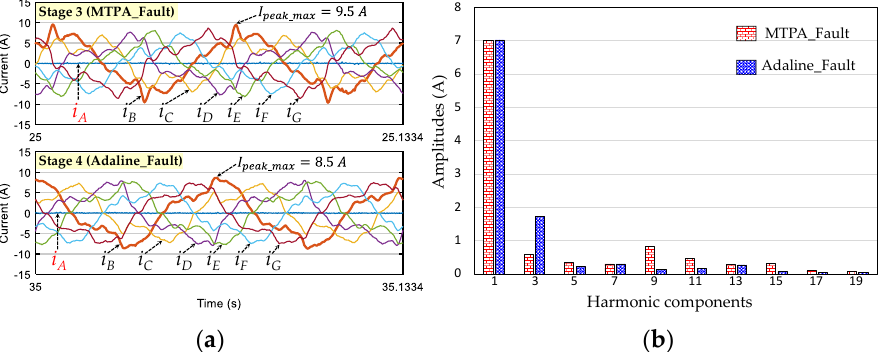
Figure 12. (Experimental result) Phase current analyses when phase A is opened at 300 rpm: ( a ) measured phase currents in stages 3 and 4; and ( b ) harmonic spectrum of phase- B current.